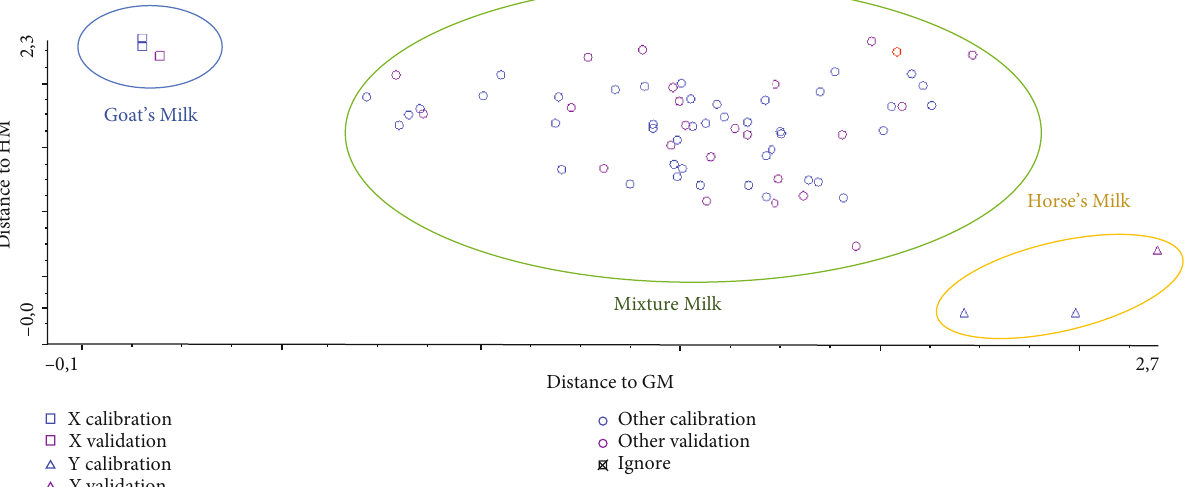
Figure 5: Cooman ’ s plot for discrimination between horse ’ s milk ( Δ ), goat ’ s milk ( □ ), and horse ’ s milk adulterated with goat ’ s milk (o).